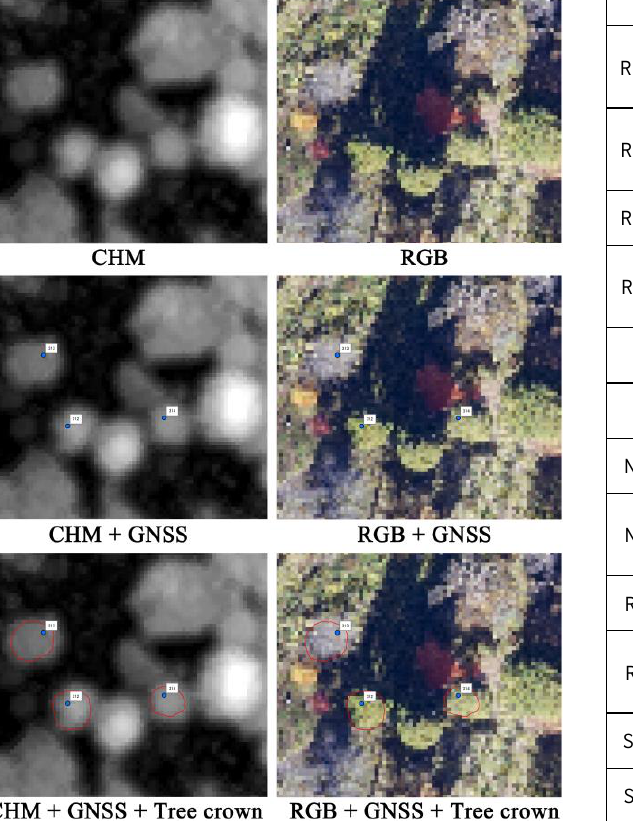
Figure 3. Manual individual tree detection